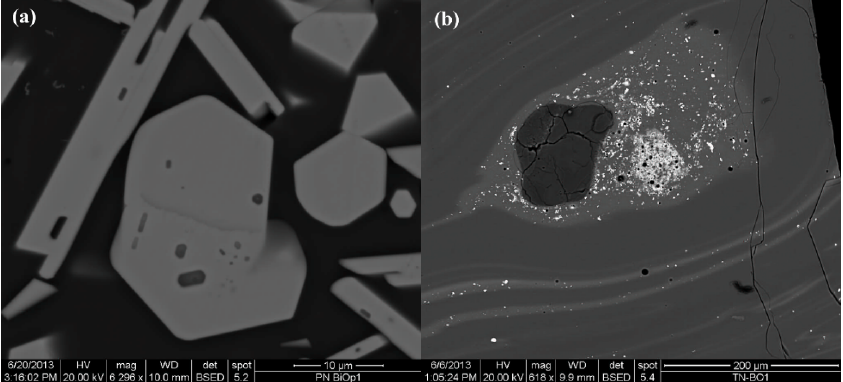
banded tesserae (PN TU2—Figure 1c, and PN AZ2—Figure 1l), macroscopically appearing turquoise with black